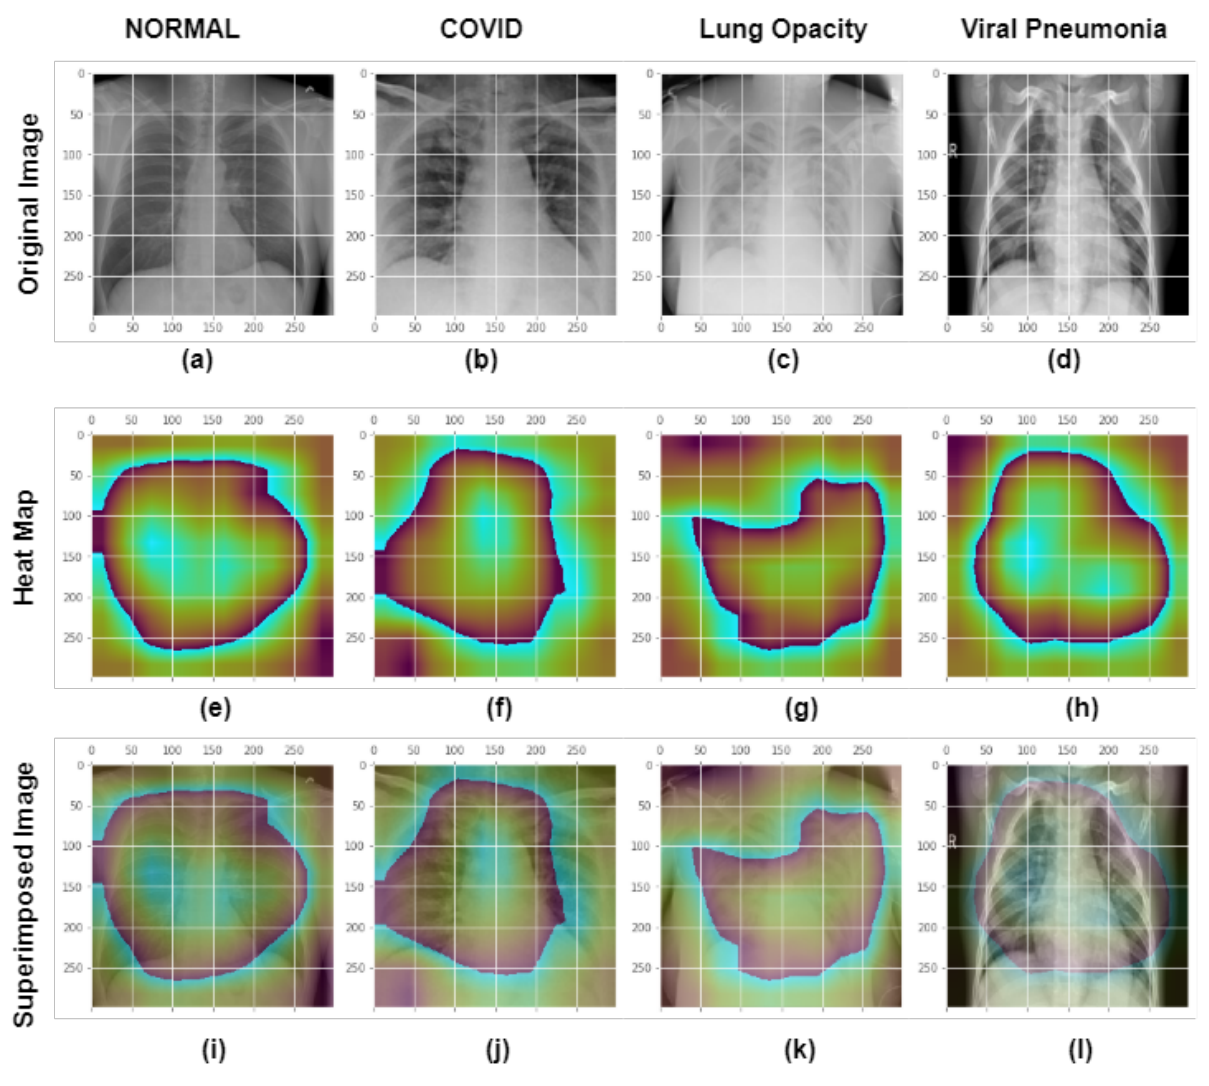
Figure 17. GradCam analysis of four class photos at the final convolution layer in the Xception model. First row or images ( a – d ): shows chest xray images of different classes. Images ( e – h ) or the second row depicts the GradCam activation mapping for the X-ray picture. Images ( i – l ) or Third row: An activation map with an X-ray image overlaid to represent the superimposed image. The Normal class’s original picture, heatmap, and overlay image are shown in the first column of the Xception model’s final convolution layer. The original picture, activation mapping, and overlay image for the COVID, Lung Opacity, and non-COVID viral pneumonia classes are shown in the second, third, and fourth columns, respectively. All the images were correctly classified in this